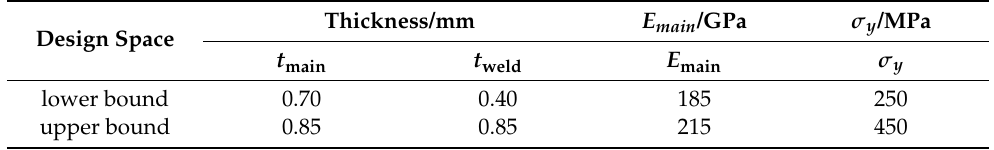
Table 4. Bounds of model parameters in spherical